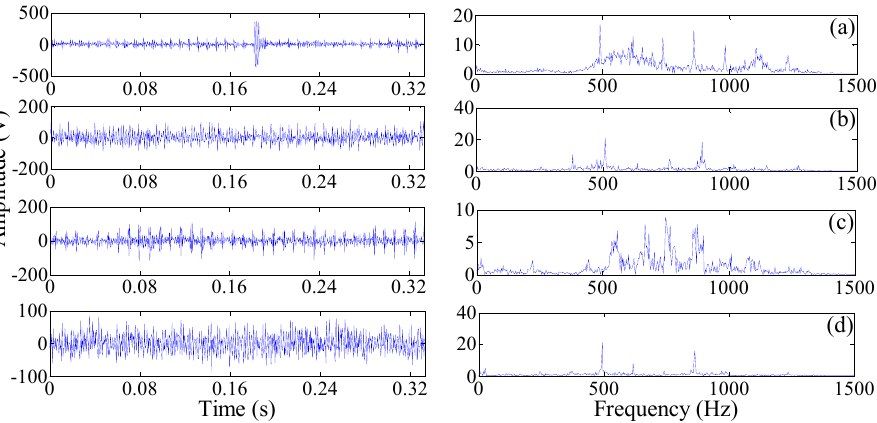
Figure 10. Example signals and their spectra of four health status patterns: ( a ) slight wear; ( b ) medium wear; ( c ) broken tooth; and ( d ) normal wear signals.